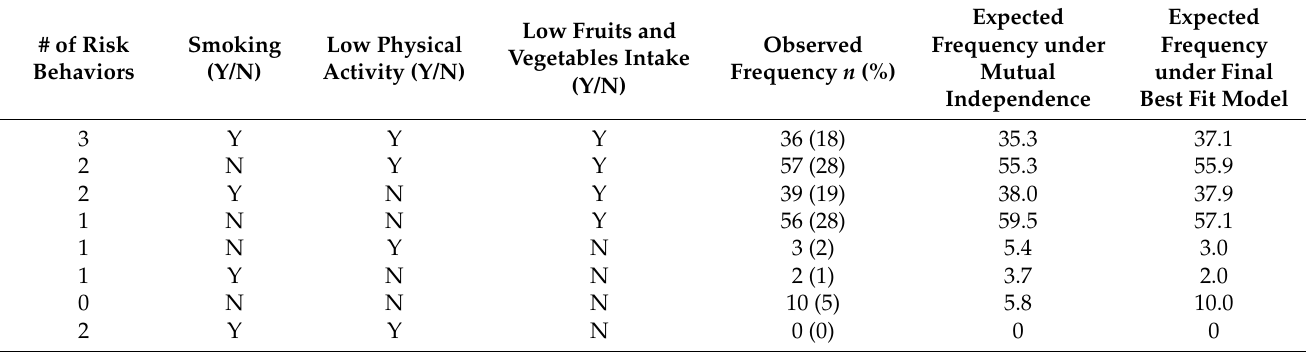
Table 3. Clustering of health risk behaviors among Latino men ( n =